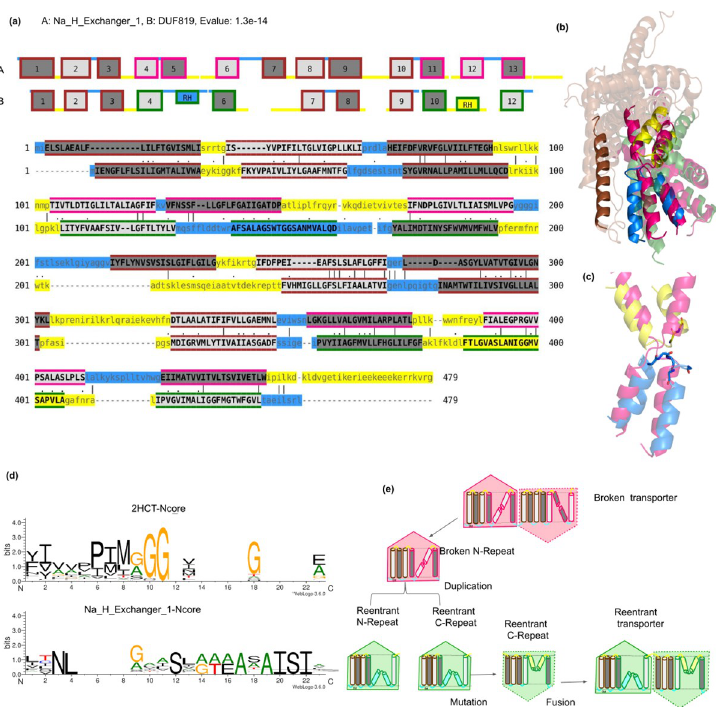
Fig 5. Broken-Reentrant transporter transitions by duplication of repeat unit. (a) Sequence and topology alignment between Na_H_Exchanger_1 (CPA-broken fold-type) and DUF819 (CPA-reentrant fold-type). All the transmembrane helices are numbered sequentially and the reentrant helix is denoted as RH (b) Structure superposition of broken and reentrant transporter. The extra scaffold helix and the broken-reentrant transition are highlighted in bright colors. (c) A zoomed-in figure of broken (pink) and reentrant helix (yellow and blue) is shown. The glycines are shown in stick representation. (d) The aligned positions of the broken and reentrant N-core helix are represented as sequence motifs (e) Cartoon representation showing the events of duplication and mutation in reentrant transporters leading to the transition of broken-reentrant transporters.